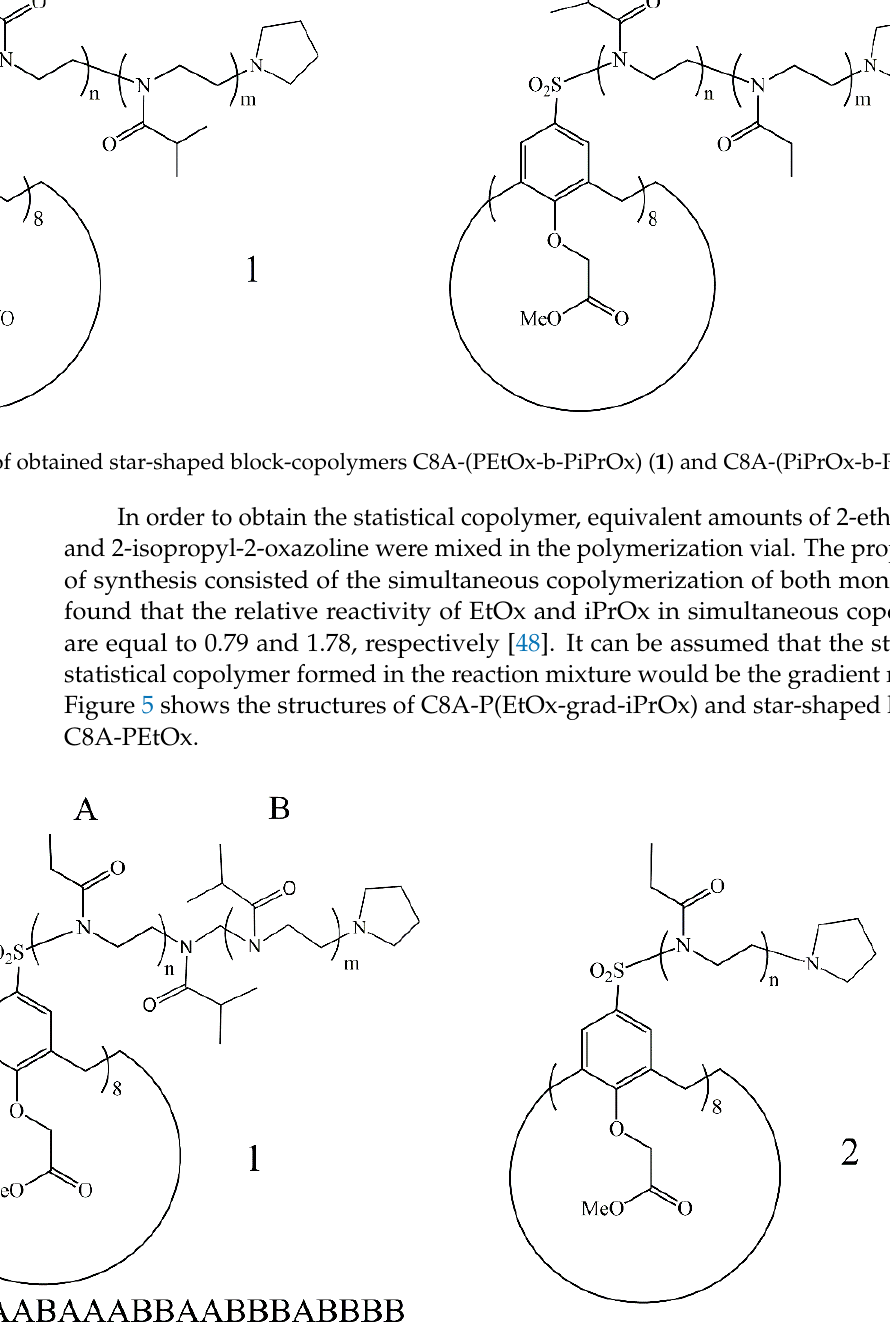
Figure 5. Structures of obtained star-shaped C8A-P(EtOx-grad-iPrOx) ( 1 ) and C8A-PEtOx ( 2 ). It is well known that the only parent calix[8]arene exists in the stable cone confor- mation due to the intramolecular H-bonding of hydroxyl groups at the lower rim while any kinds of chemical transformation of these moieties leads to conformationally labile structures that are clearly visible in the NMR spectra. It was found that methylene protons of the macrocycle did not exhibit the AB quartet that is typical for the core conformer and had no more complicated signals that are typical for paco or the other conformers